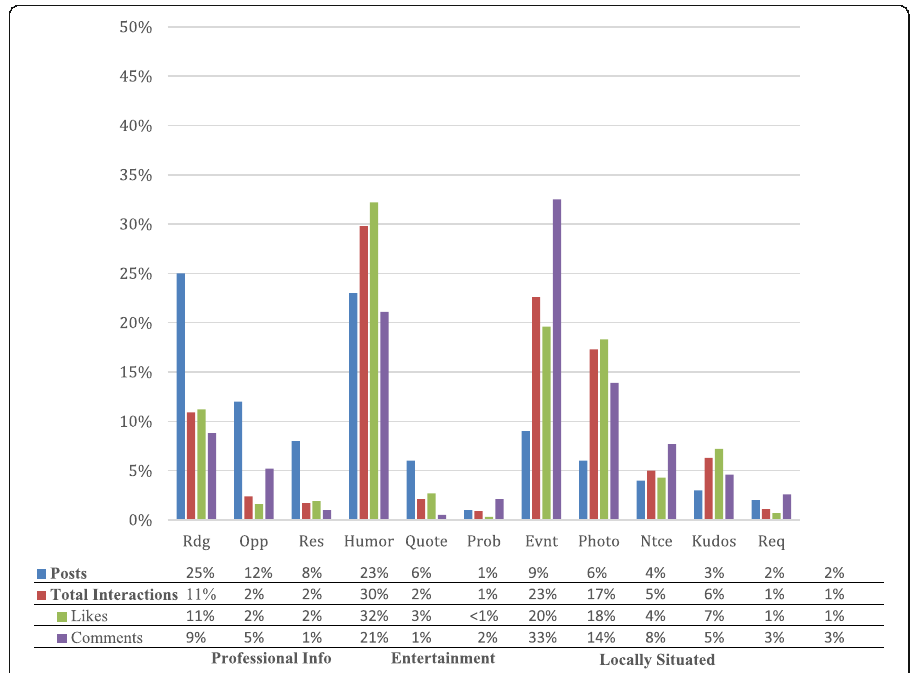
Fig. 1 Proportion of Interactions by Post Category